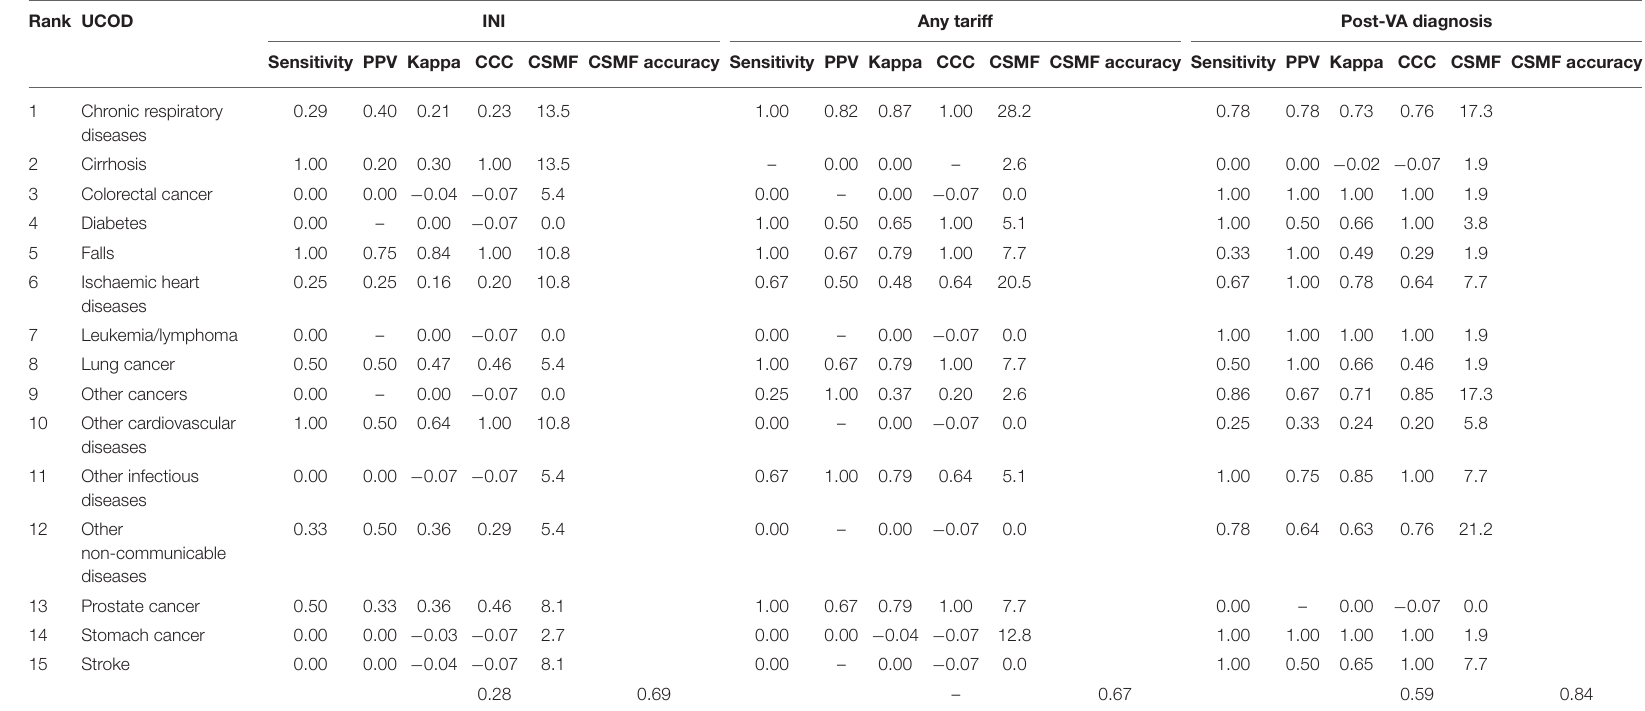
TABLE 8 | Validation metrics comparing initial diagnosis, any Tariff or post-VA diagnosis, with MRR UCOD (top 15 specific UCOD) of the 53 cases where diagnosis changed. Rank UCOD INI Any tariff Post-VA